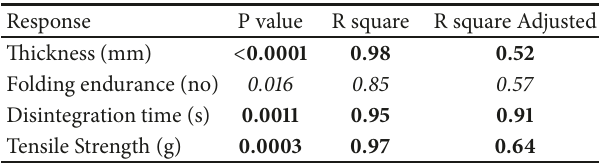
Table 4: ANOVA result (P value) of each response (thickness, folding endurance, disintegration time, and tensile strength).